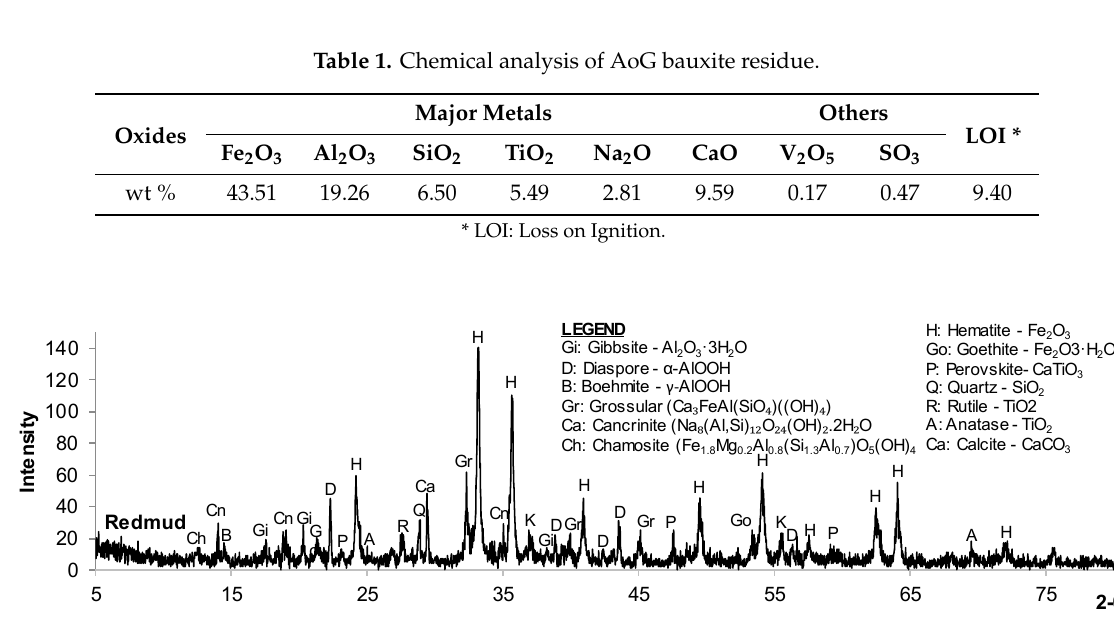
Figure 3. XRD (X-ray di ff raction) mineralogical analysis of AoG bauxite residue. Table 1. Chemical analysis of AoG bauxite residue.